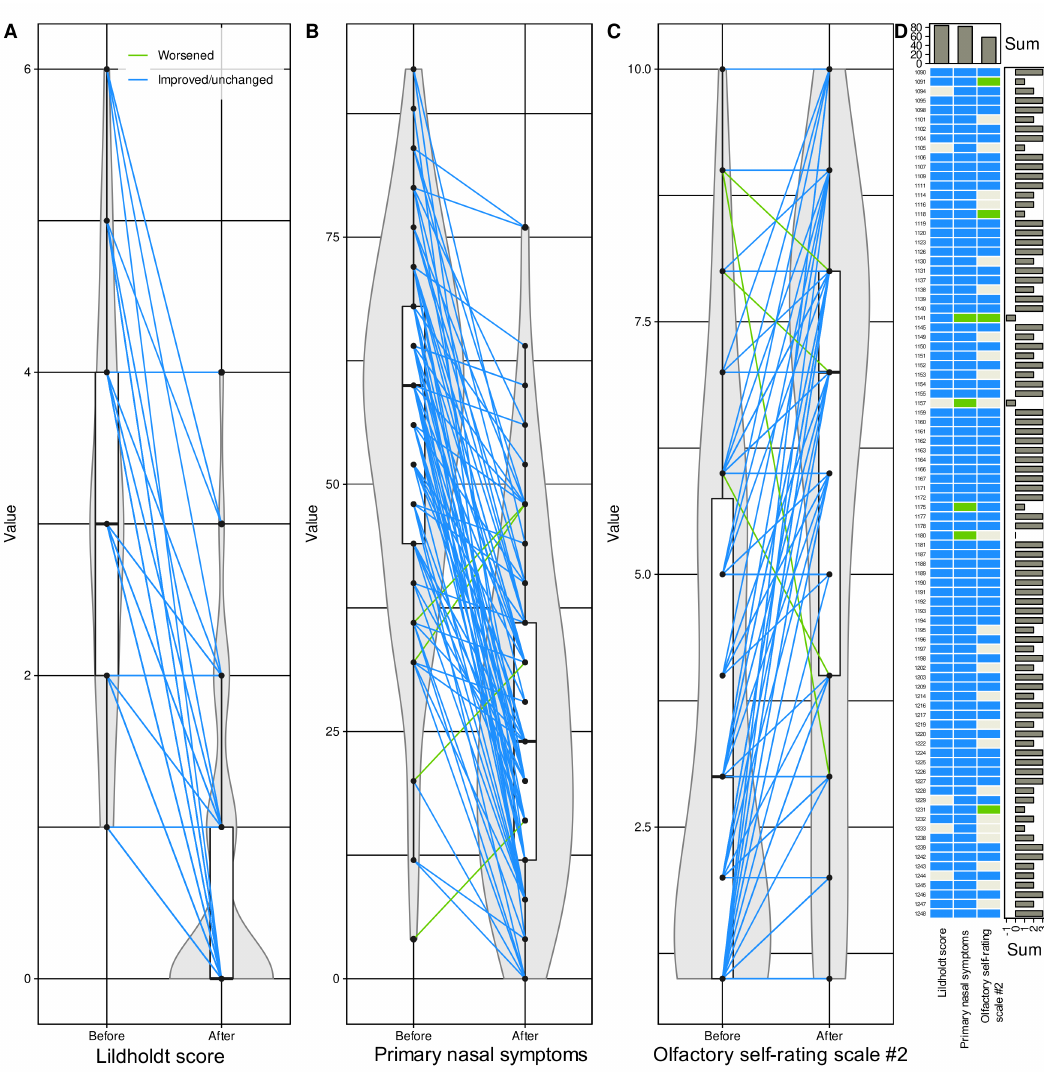
Figure 6. Subset of d = 6 variables found during the machine learning-based feature selection (Figure 4) to be, out of d = 37 variables, those carrying relevant information about whether a dataset instance has been acquired before or after endoscopic nasal sinus surgery. ( A – C ) Individual data points are shown as dots; please note that they may overlap for ordinally scaled variables. Individual measurements are connected by straight lines between baseline and postoperative values, colored blue for changes towards improvement of the respective parameters and colored green if signs or symptoms worsened after surgery. The points are plotted on violin plots showing the probability density distribution of the variables and are overlaid with boxplots showing more basic descriptive statistics. The boxes have been constructed using the minimum, quartiles, median (solid line within the box), and maximum. The whiskers add 1.5 times the interquartile range (IQR) to the 75th percentile or subtract 1.5 times the IQR from the 25th percentile. ( D ) Matrix heat plot color-coding the direction of change in each of the six variables in panels ( A – C ) from before to after surgery. The signs were adjusted to indicate improvement (blue) or no improvement (green) across all parameters. Marginal sums are shown as barplots. The figure has been created using the R software package (version 4.1 for Linux; http://CRAN.R-project.org/ (16 September 2021) [47]), and the R libraries “ggplot2” (https://cran.r-project.org/package=ggplot2 (accessed on 16 September 2021)